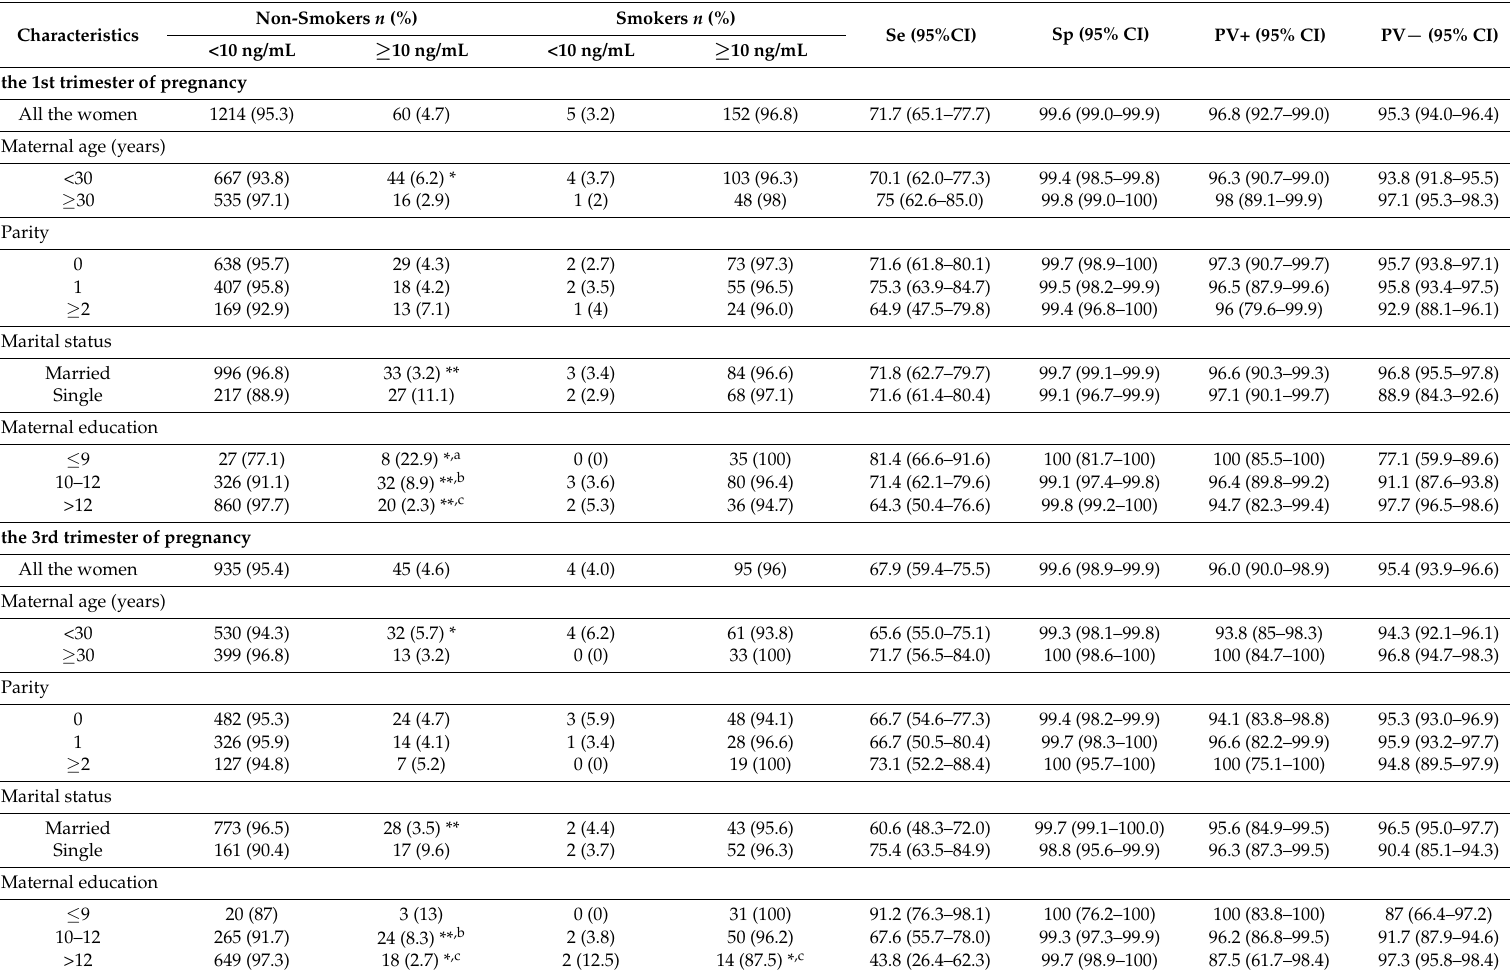
Table 4. Sensitivity (Se), specificity (Sp), positive and negative predictive values (PV+, PV − ) according to the saliva cotinine cut-off of 10 ng/mL.